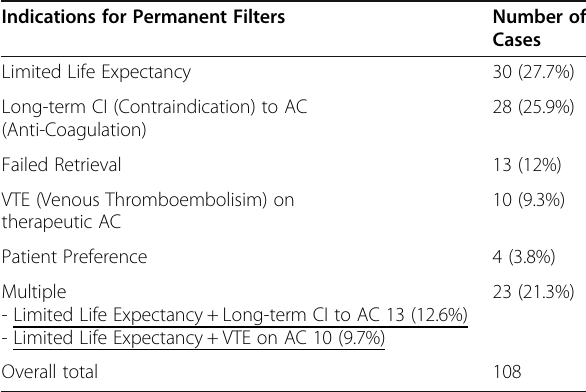
Table 1 Indications for Permanent Filters ( n = 108) Indications for Permanent Filters